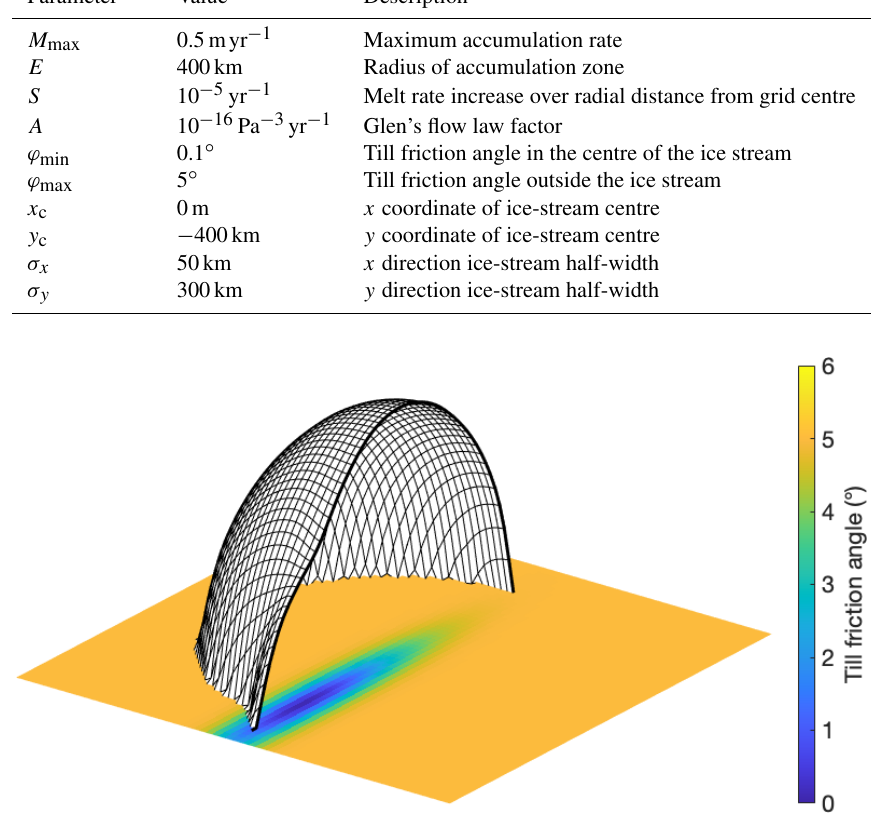
Figure 2. Bed roughness and steady-state ice-sheet geometry in the EISMINT-based experiment, experiment I. Black lines on the ice surface are just for illustration. They do not correspond to the model